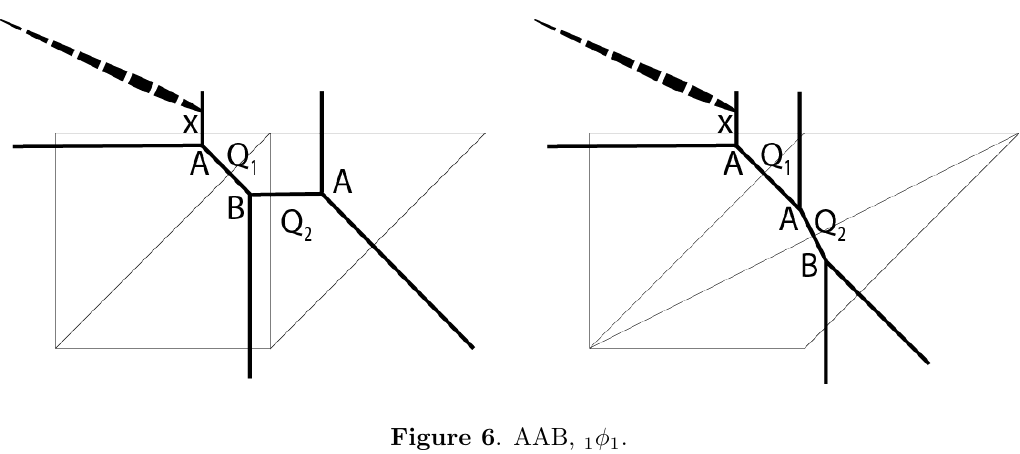
Figure 6 . AAB, 1 (cid:30) 1